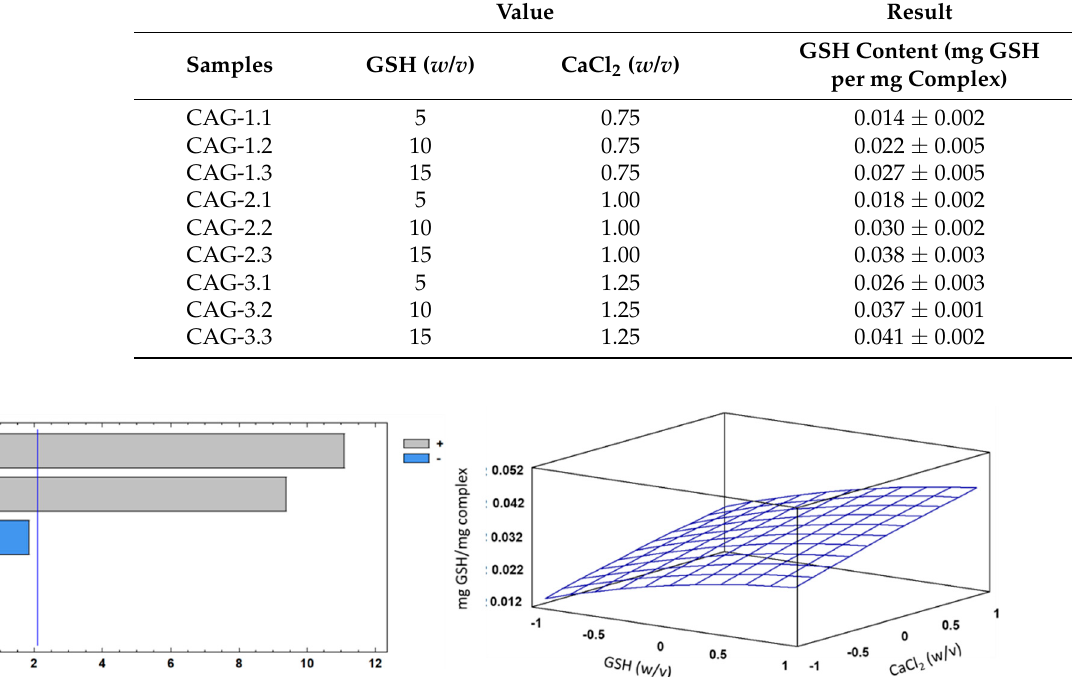
Table 2. Concentration of GSH inside the CAG complexes. Table 3. ANOVA results for the response surface regression model on GSH encapsulation.